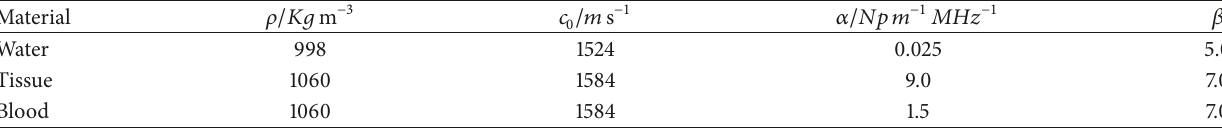
Table 1: Values of acoustic parameters in this study.